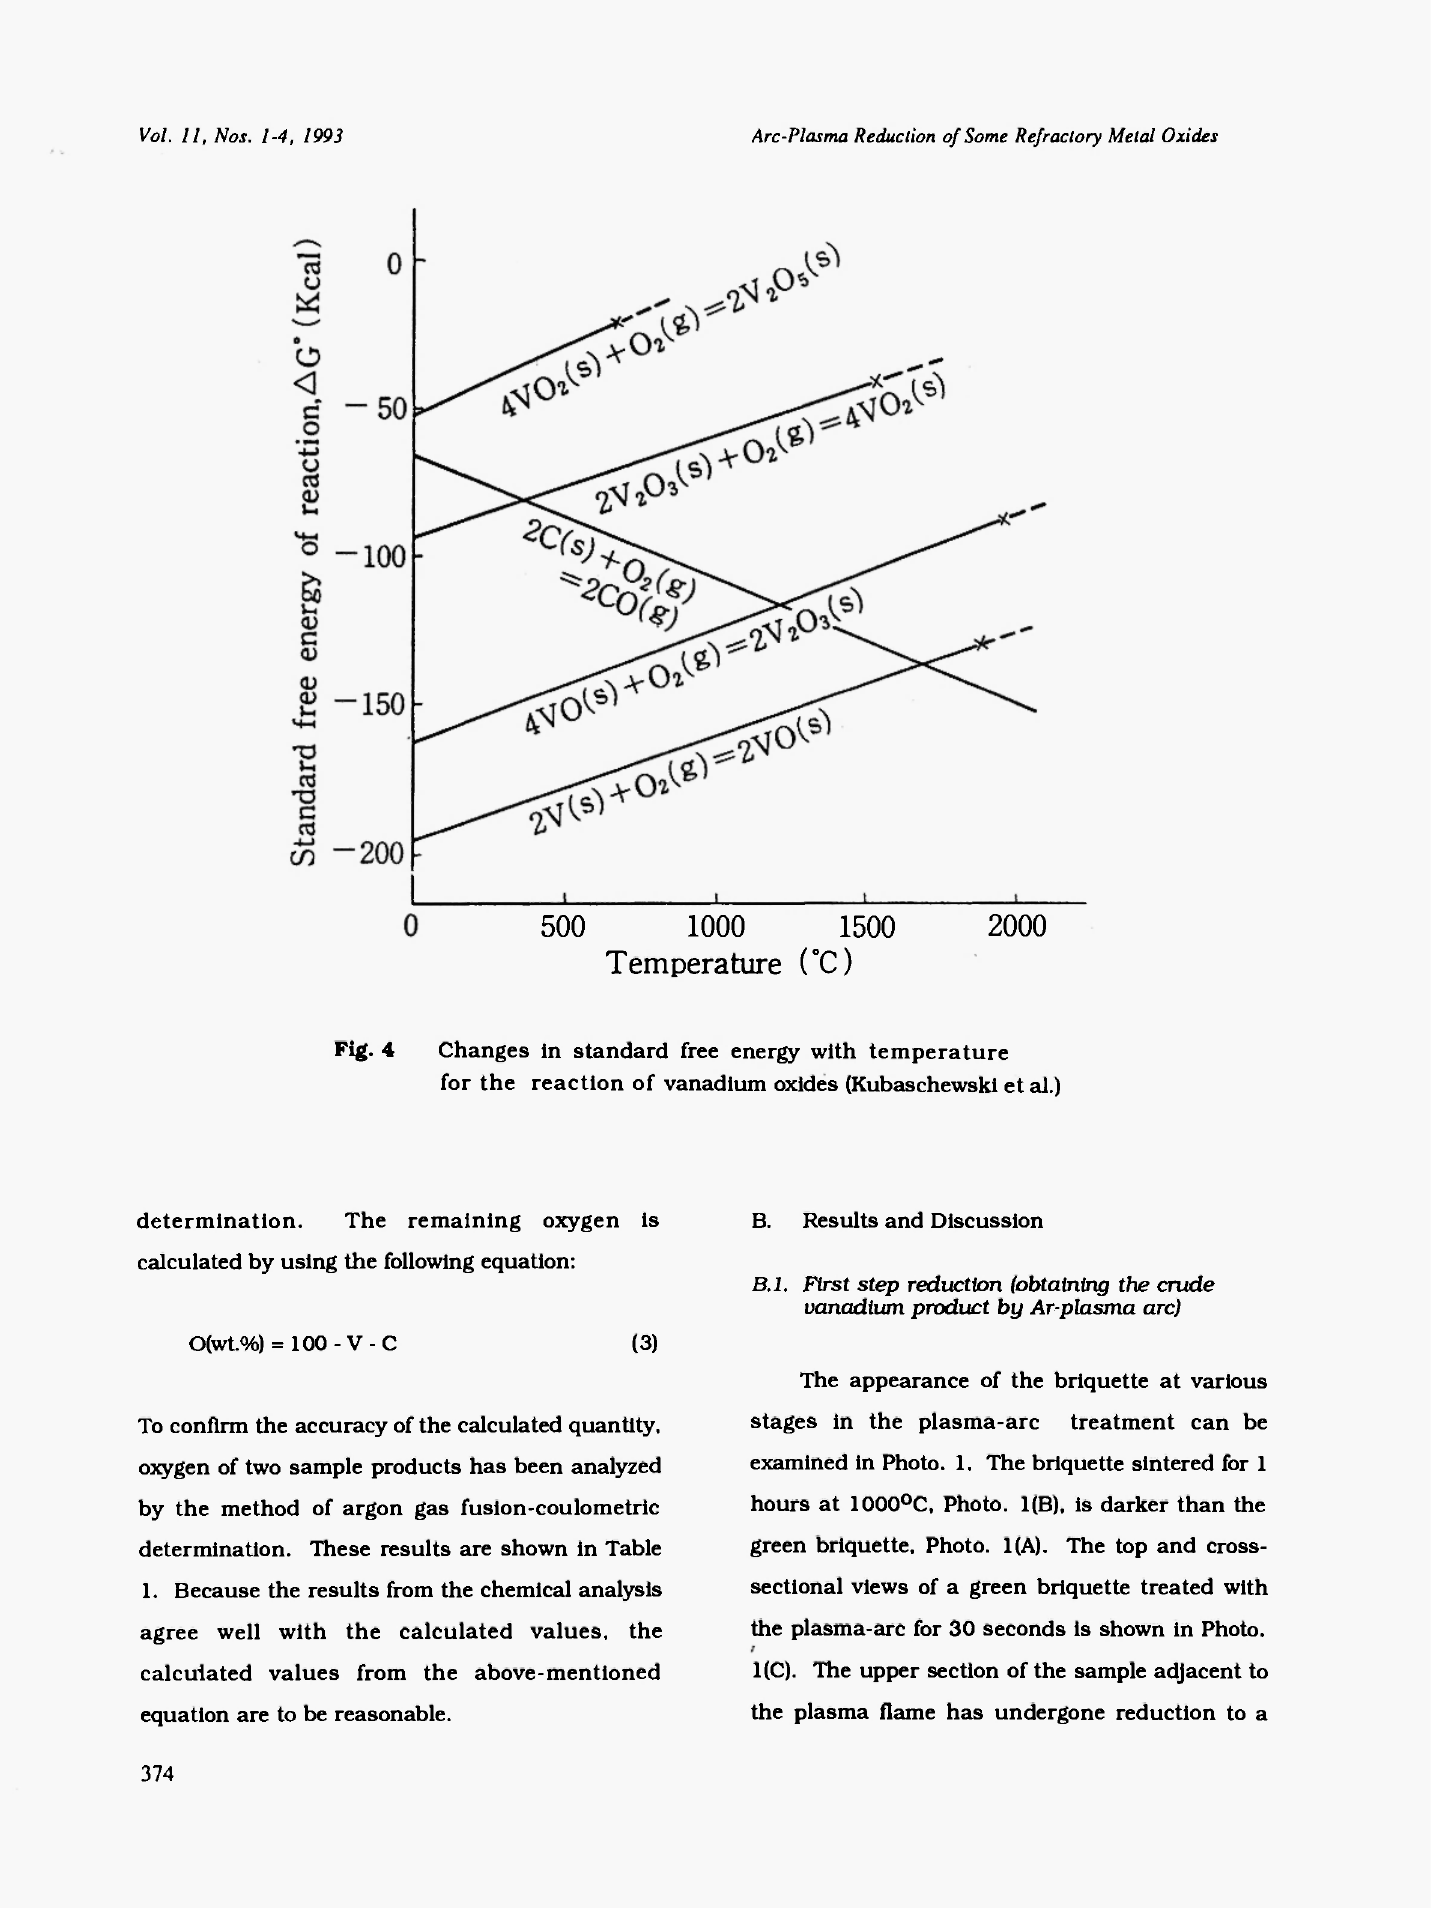
Fig. 4 Changes in standard free energy with temperature for the reaction of vanadium oxides (Kubaschewski et al.)